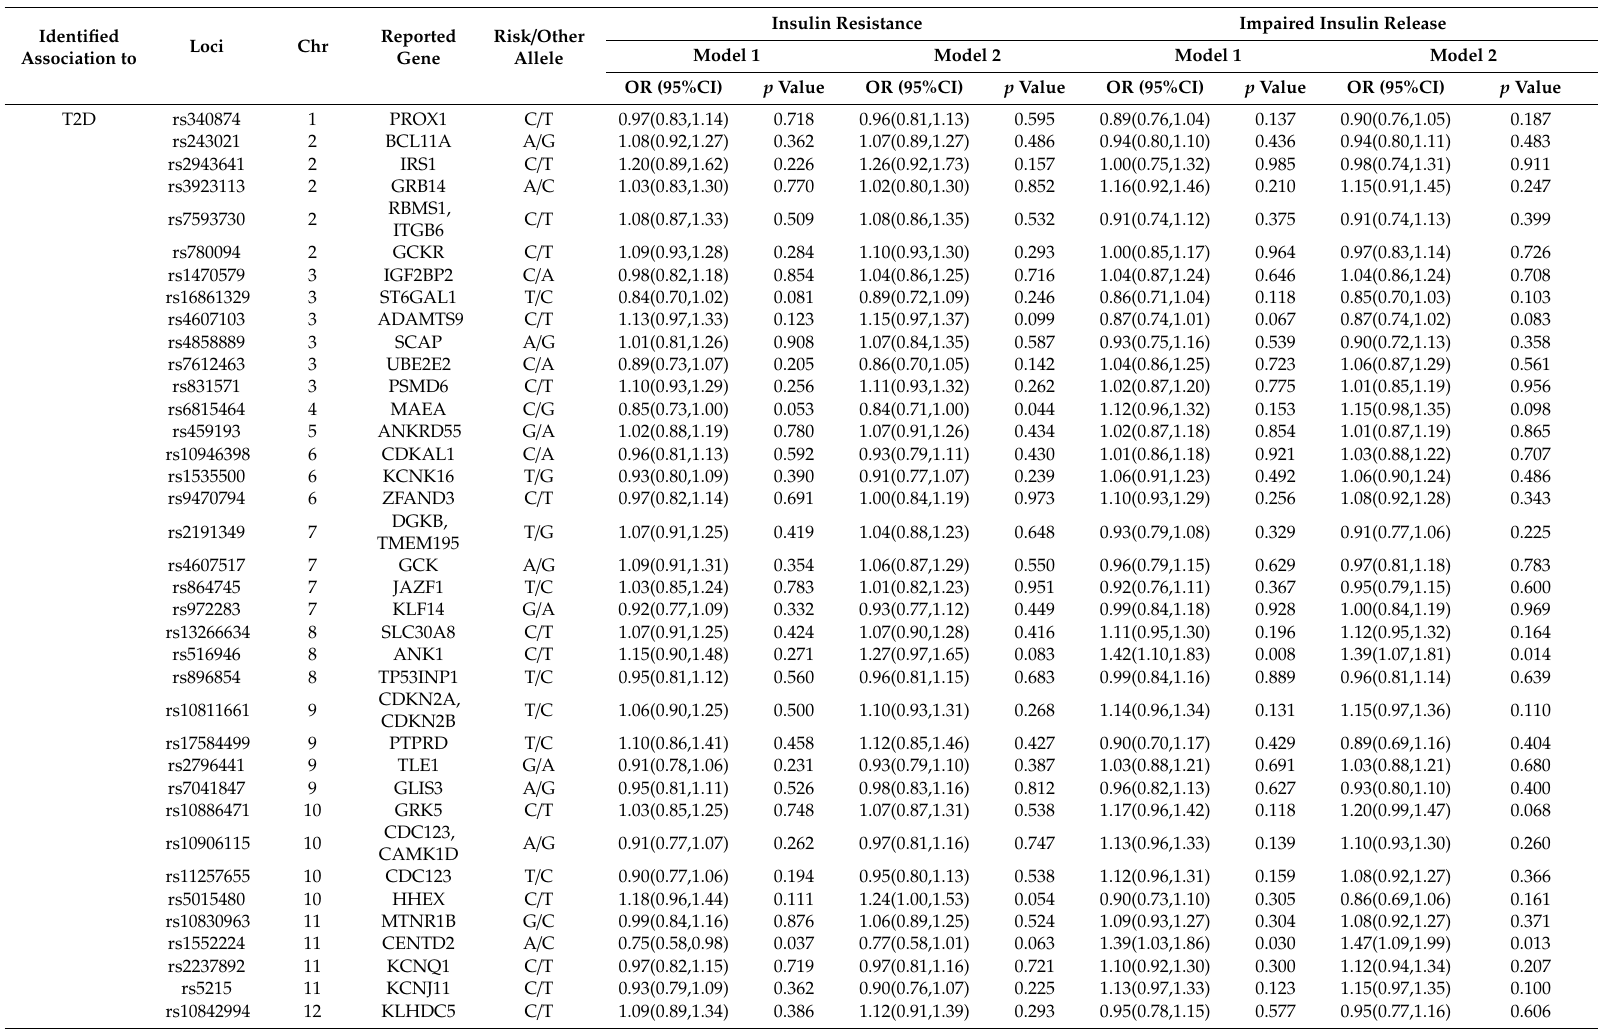
Table 2. Association between each SNP and quantitative traits of